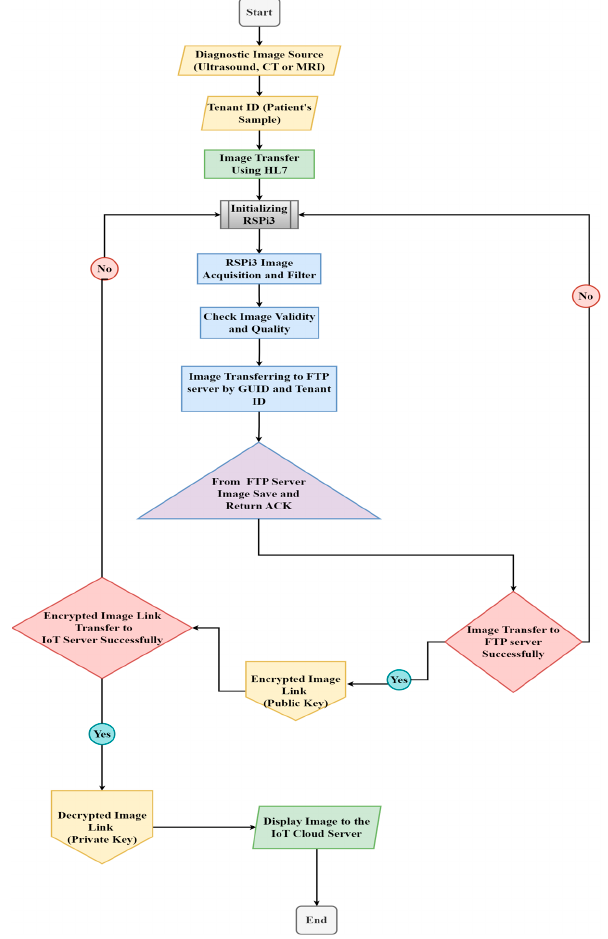
Figure 1. Flow chart of the whole process.